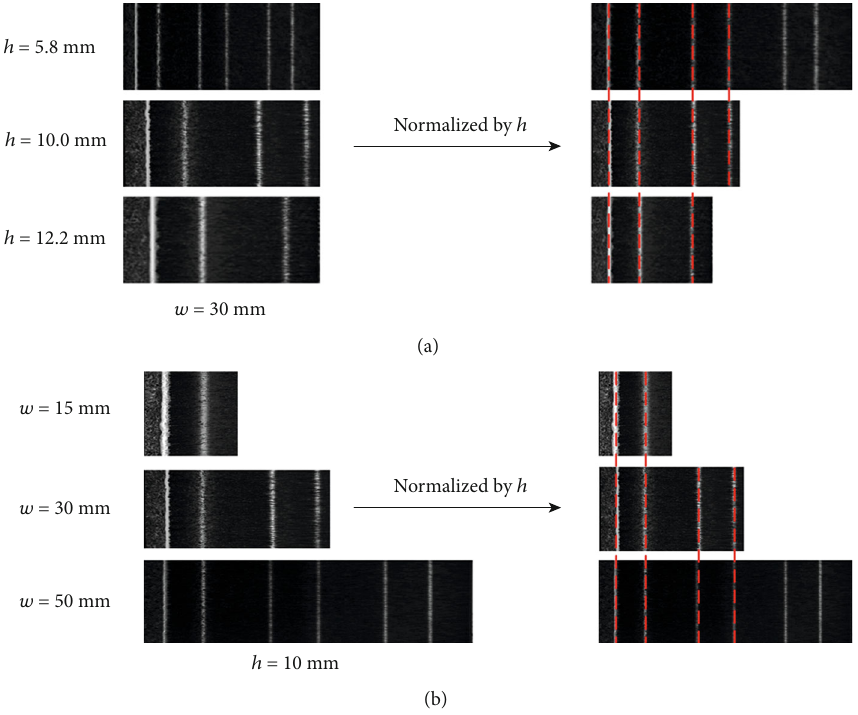
Figure 7: Results of the oil fl ow visualization for di ff erent gap (a) heights and (b) widths. Table 2: Length of the secondary fl ows and separation bubbles for di ff erent gap widths and heights. Gap width (mm) Gap height (mm)